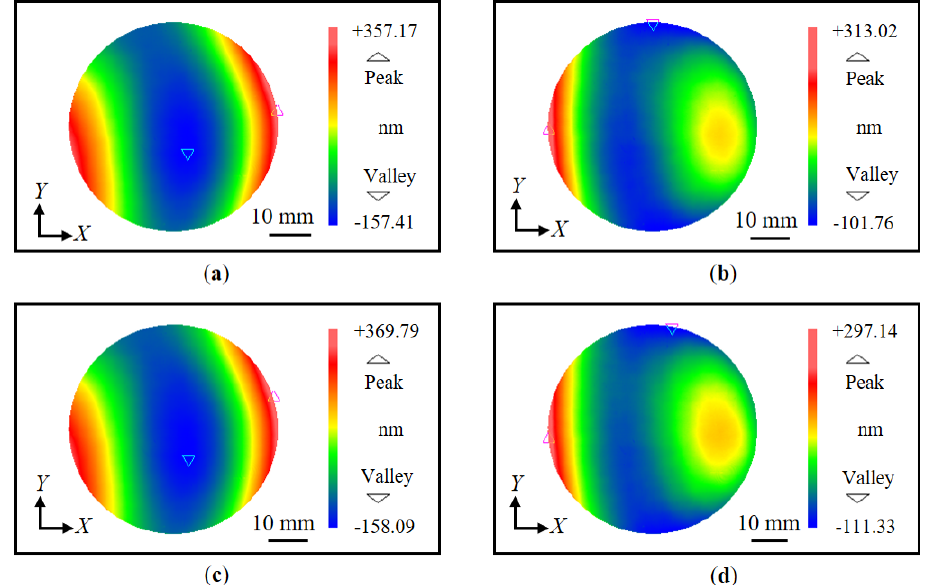
Figure 12. Measured diffracted wavefronts before and after shift ( X -direction): ( a ) Measured positive first-order diffracted wavefront before the shift; ( b ) Measured negative first-order diffracted wavefront before the shift; ( c ) Measured positive first-order diffracted wavefront after the shift; ( d ) Measured negative first-order diffracted wavefront after the shift.